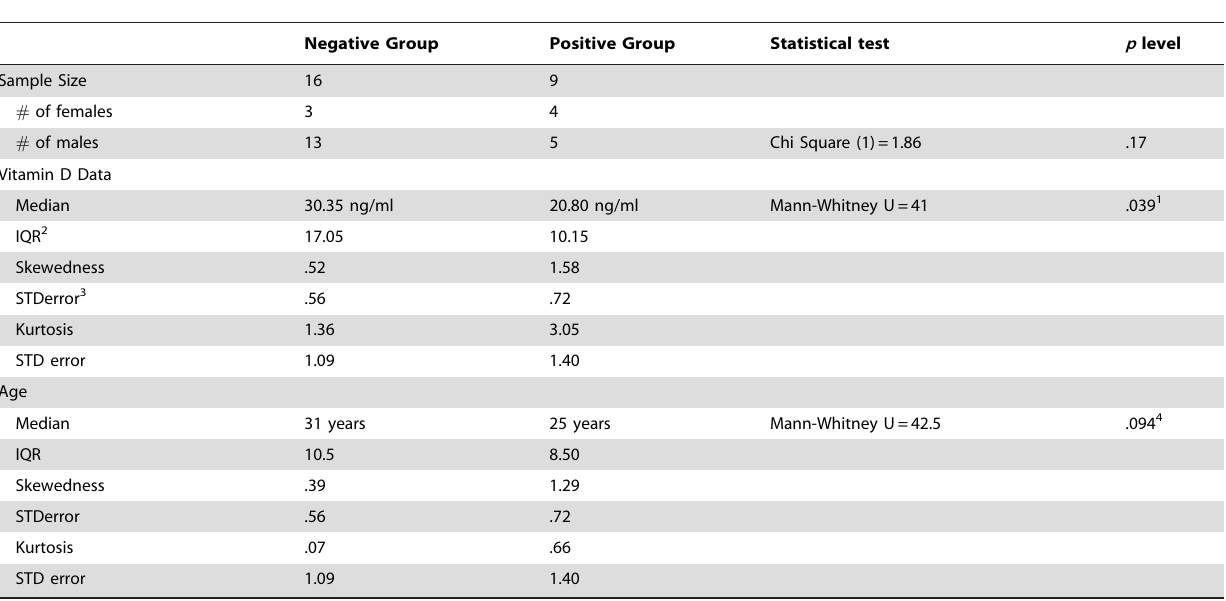
Table 1. A comparison of group data for those with positive and negative monospot test